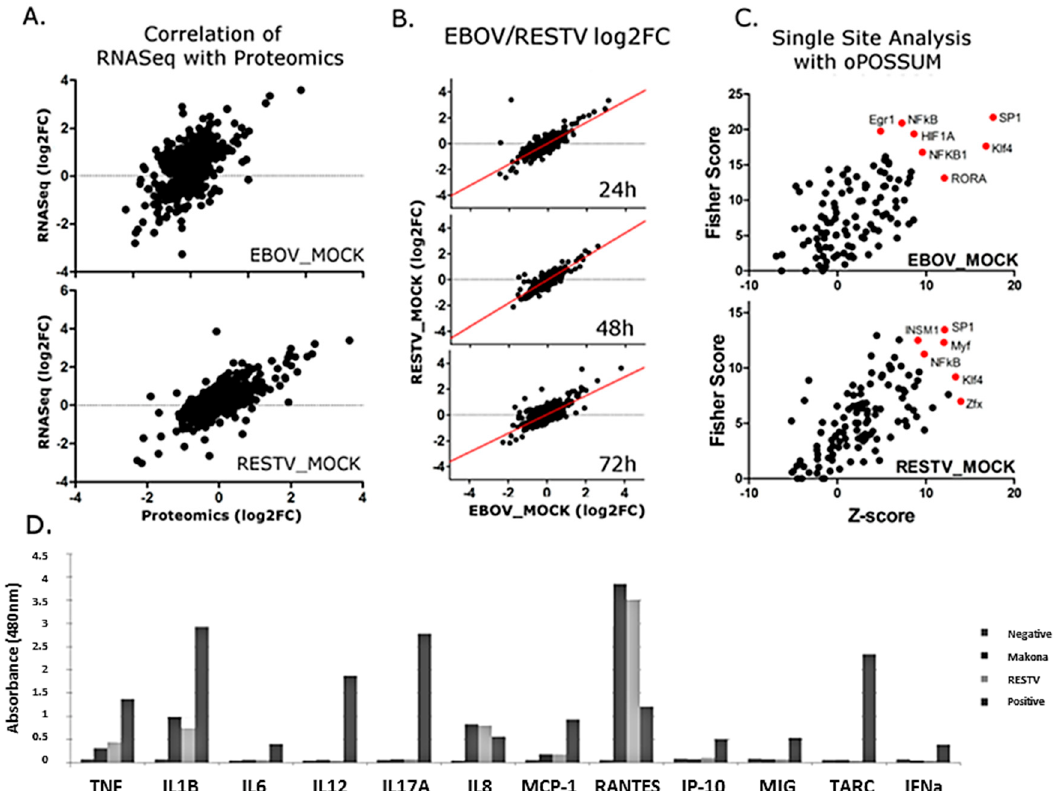
Figure 6. ( A ) Shown is data amalgamated from all three time points assayed (24, 48, and 72 h post-infection). An R 2 value was calculated by Pearson Correlation showing a correlation of 0.85 for RESTV, and a correlation of 0.64 for EBOV ( p ≤ 0.01); where this value is greater than 0.5, it indicated a positive correlation between these sample datasets. The confidence in this analysis is indicated by p -value. Each data point shown illustrates a particular transcript and corresponding protein abundance measurements at 24, 48, or 72 h. ( B ) Separate graphs were shown for protein abundance data acquired from Makona- or RESTV-infected THP-1 cells. ( C ) oPOSSUM upstream analysis demonstrating upstream regulators common to proteins, showing significant changes in abundance at both protein and transcript level. ( D ) Results of a multi-analyte ELISA analysis of supernatant collected from Makona- and RESTV-infected THP-1 derived macrophages at 72 h post-infection. The abundance of the protein identified in supernatant correlates with the optical density measured by a spectrophotometer at 480 nm. Negative control (supernatant only) is shown alongside supernatants from Makona-infected cells, RESTV-infected cells, and positive control (from LPS-stimulated THP-1).